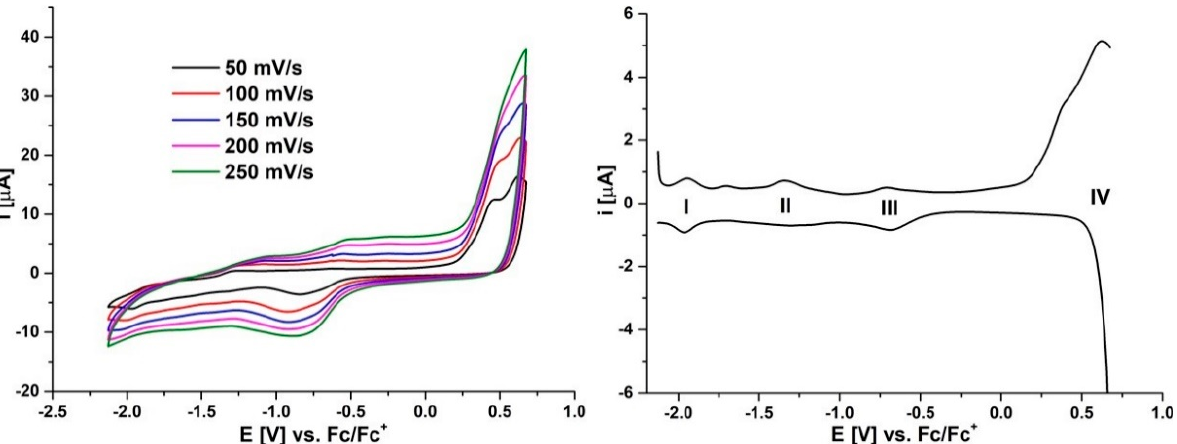
Figure 2. The cyclic and differential pulse voltammograms of porphyrazine 4 in 0.1 M TBAP/DCM. The DPV parameters: modulation amplitude 20 mV and step rate 5 mV·s − 1 .